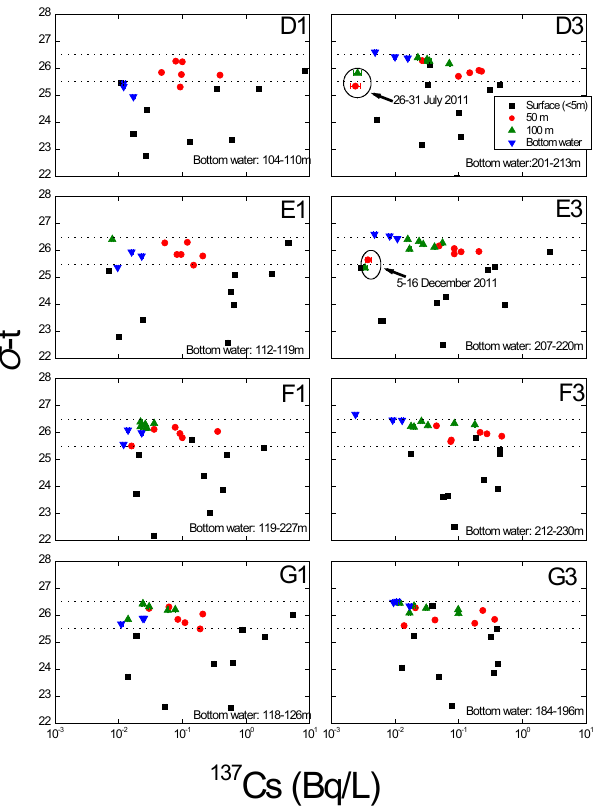
Fig. 7. Relationship between 137 Cs concentration and σ t at each sampling depth. Dashed lines indicate the σ t value range of 25.5– 26.5. Error bars are less than or equal to the size of the